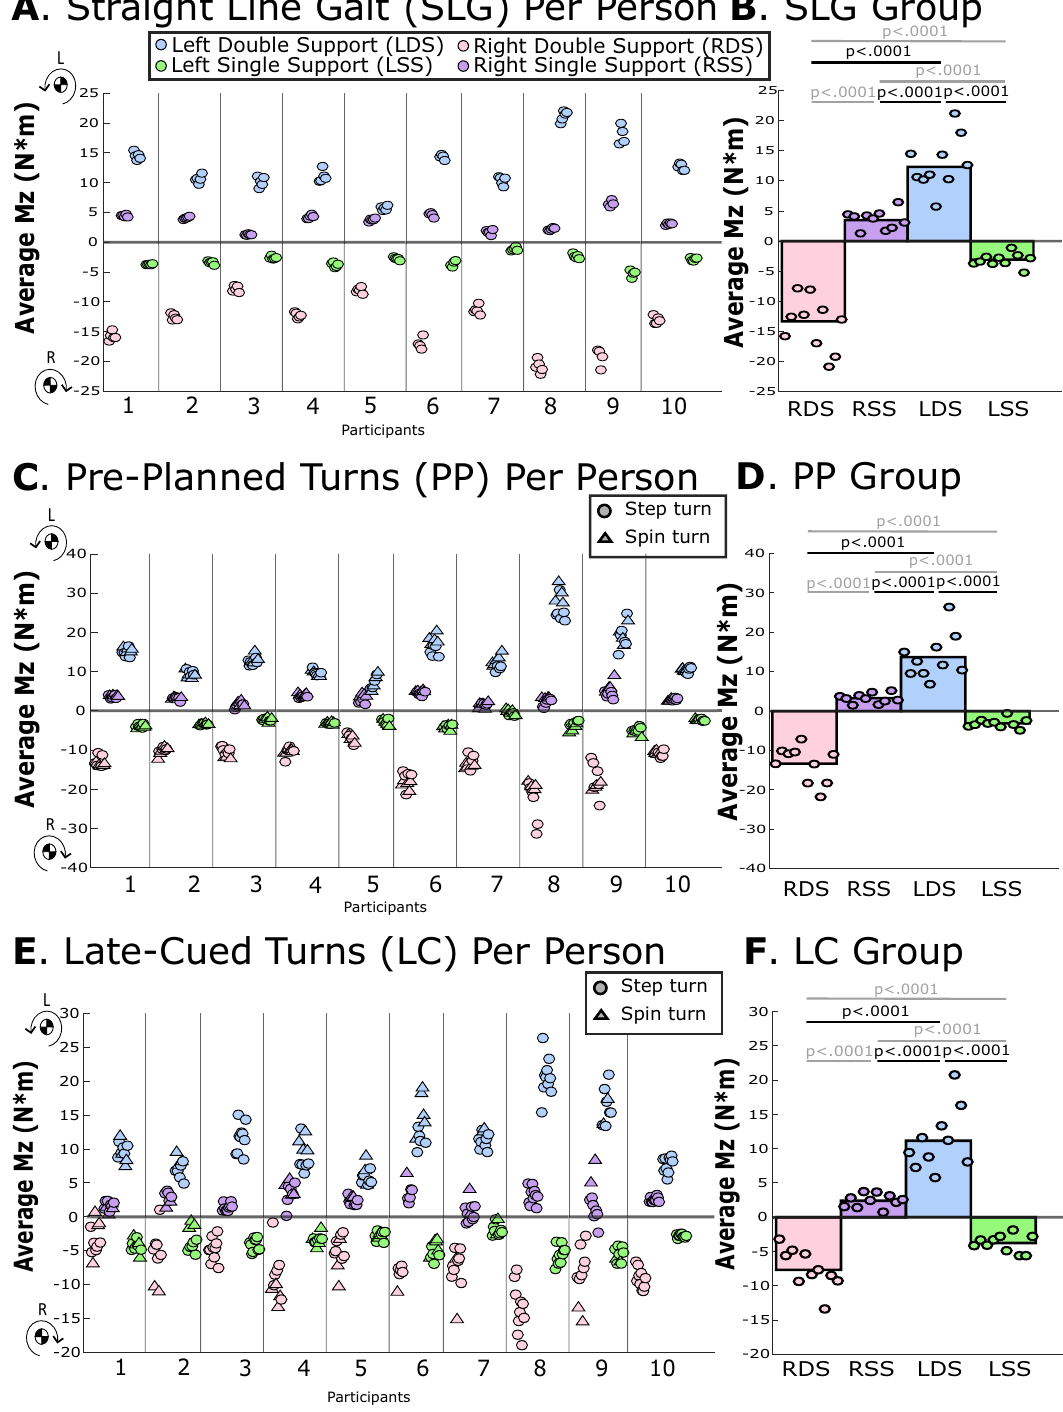
Figure 6. The average transverse-plane moment about a vertical axis through the COM (M z,avg ) for each gait phase during ( A , B ) straight-line gait, ( C , D ) pre-planned turns, and ( E , F ) late-cued turns. Positive M z,avg is leftward in the direction of the turn. The left panel ( A , C , E ) provides average M z,avg for each gait phase, each trial, and each participant, with step turns indicated with circles and spin turns indicated with triangles. In the right panel ( B , D , F ), each circle indicates the average value for each participant across multiple trials and the bar represents the across-participant (group) averages. Horizontal lines with p-values indicate statistically significant differences between gait phases at the group level, those in gray are significant differences that were not related to the